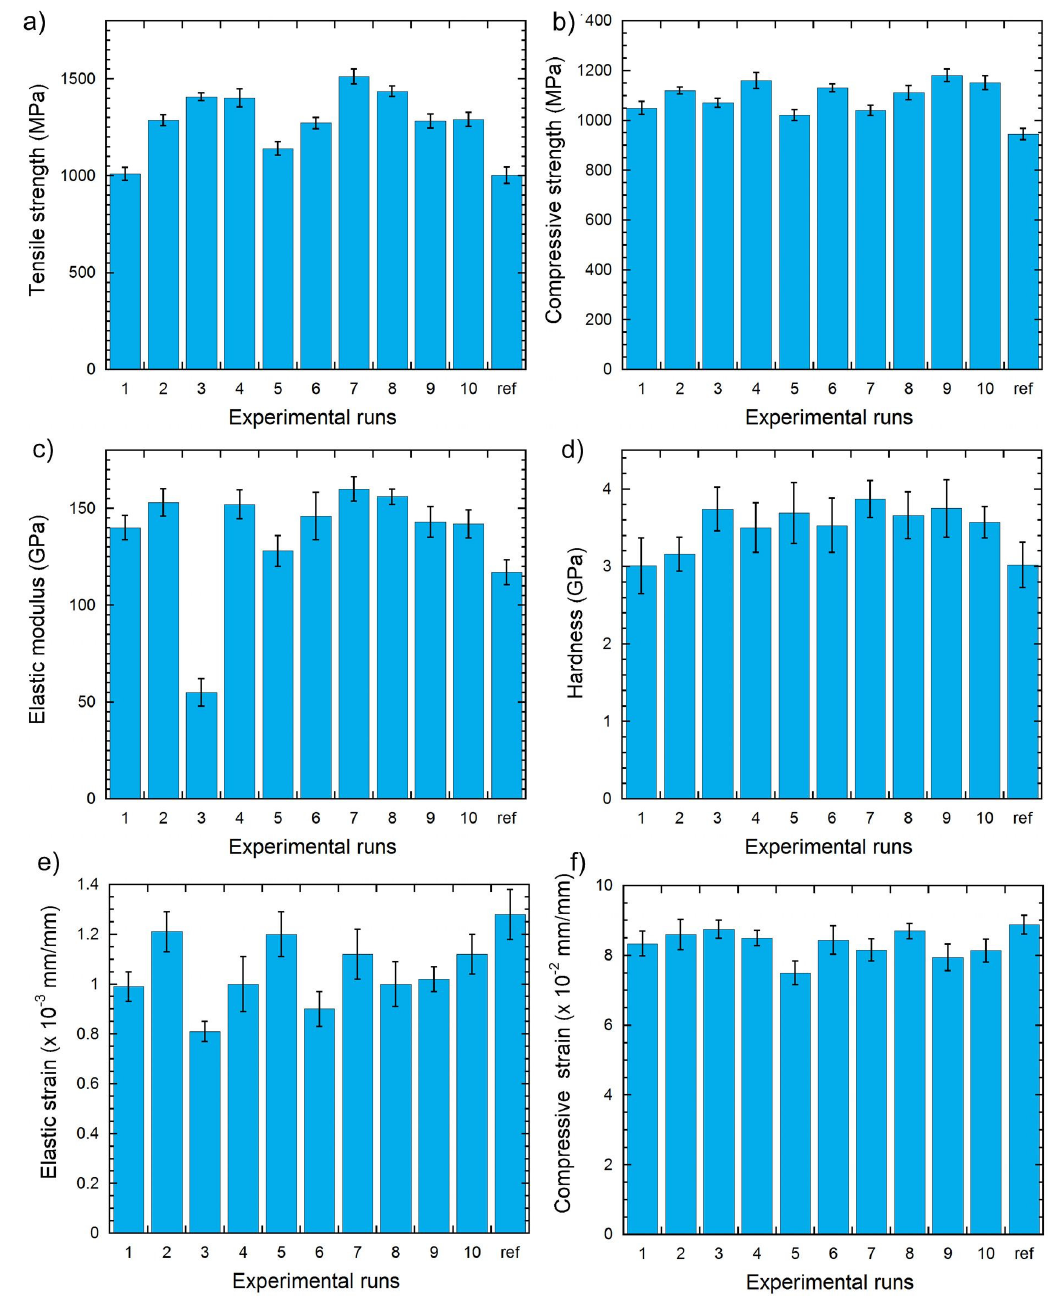
Figure 2. Variation in experimental values at varying formulation of the reinforcement with regards to ( a ) tensile strength, ( b ) compressive strength, ( c ) elastic modulus, ( d ) hardness, ( e ) elastic strain, and ( f ) compressive strain.